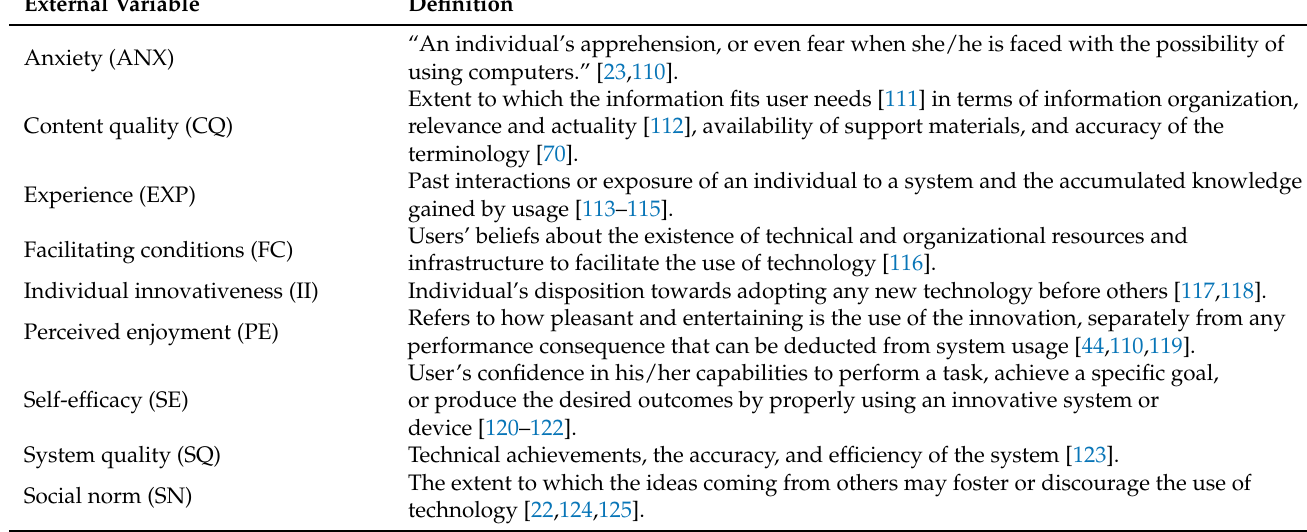
Table 3. Definitions of the